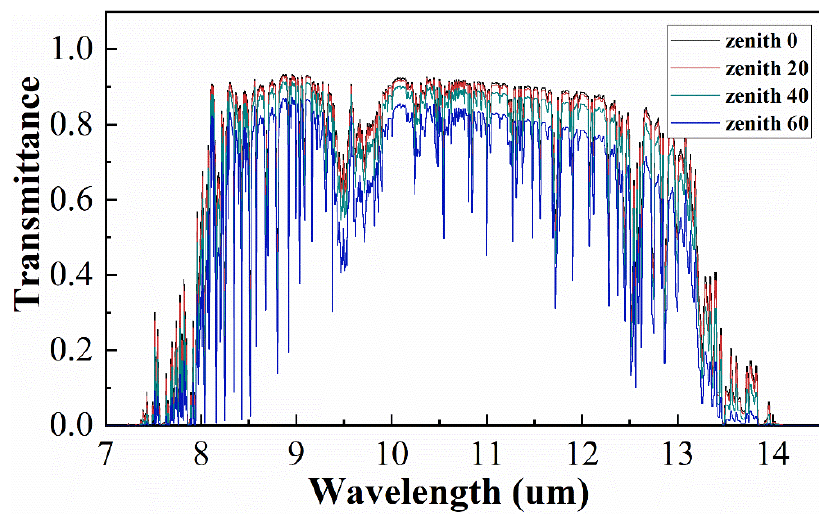
Figure 4. Variation of atmospheric transmittance with sensor zenith angle.